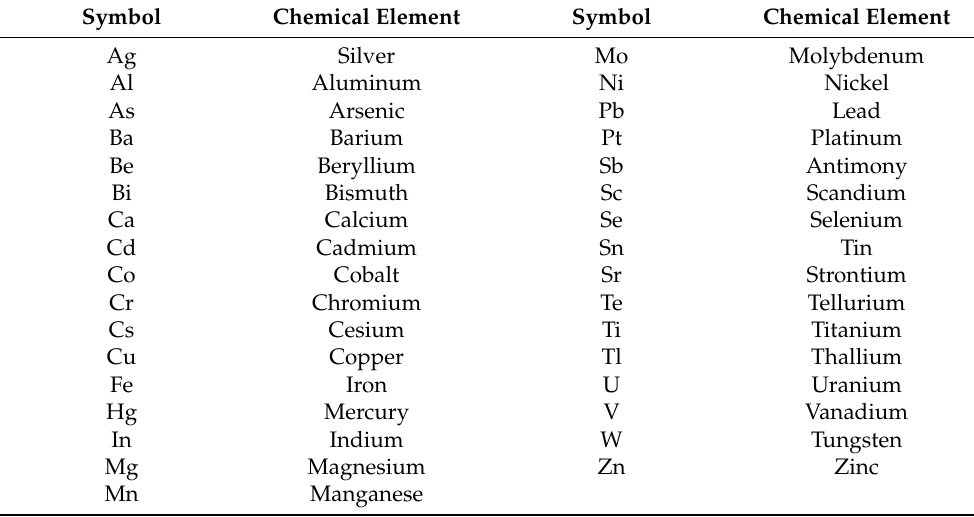
Table 2. Chemical symbols of the elements and cited in this